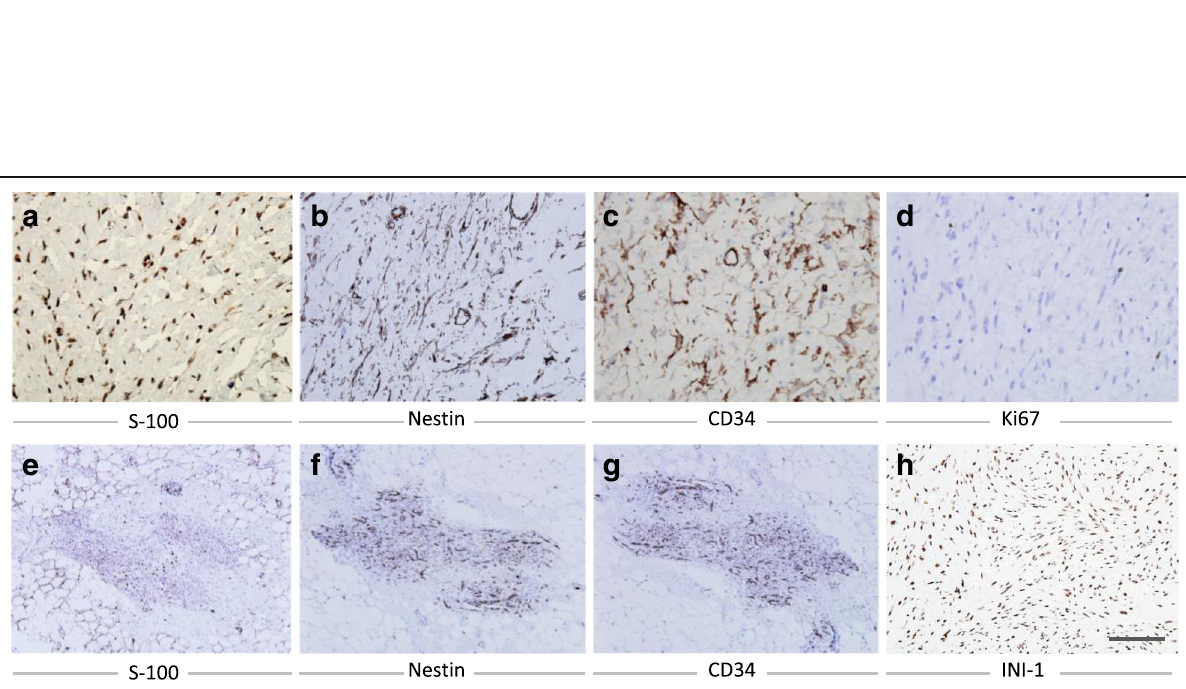
Fig. 4 Images of immunohistochemical results of ossifying fibromyxoid tumors. Lesion cells stain positive for S-100, nestin, CD34 and INI-1 ( a-c, h ). 2% lesion cells stain positive for Ki67 ( d ). Small lesions in the tissues adjacent to the tumor show positive stain for S-100, nestin and CD34 ( e-g ). Scale bar: 100 μ m ( e-g ), 50 μ m ( h ), 25 μ m ( a-d